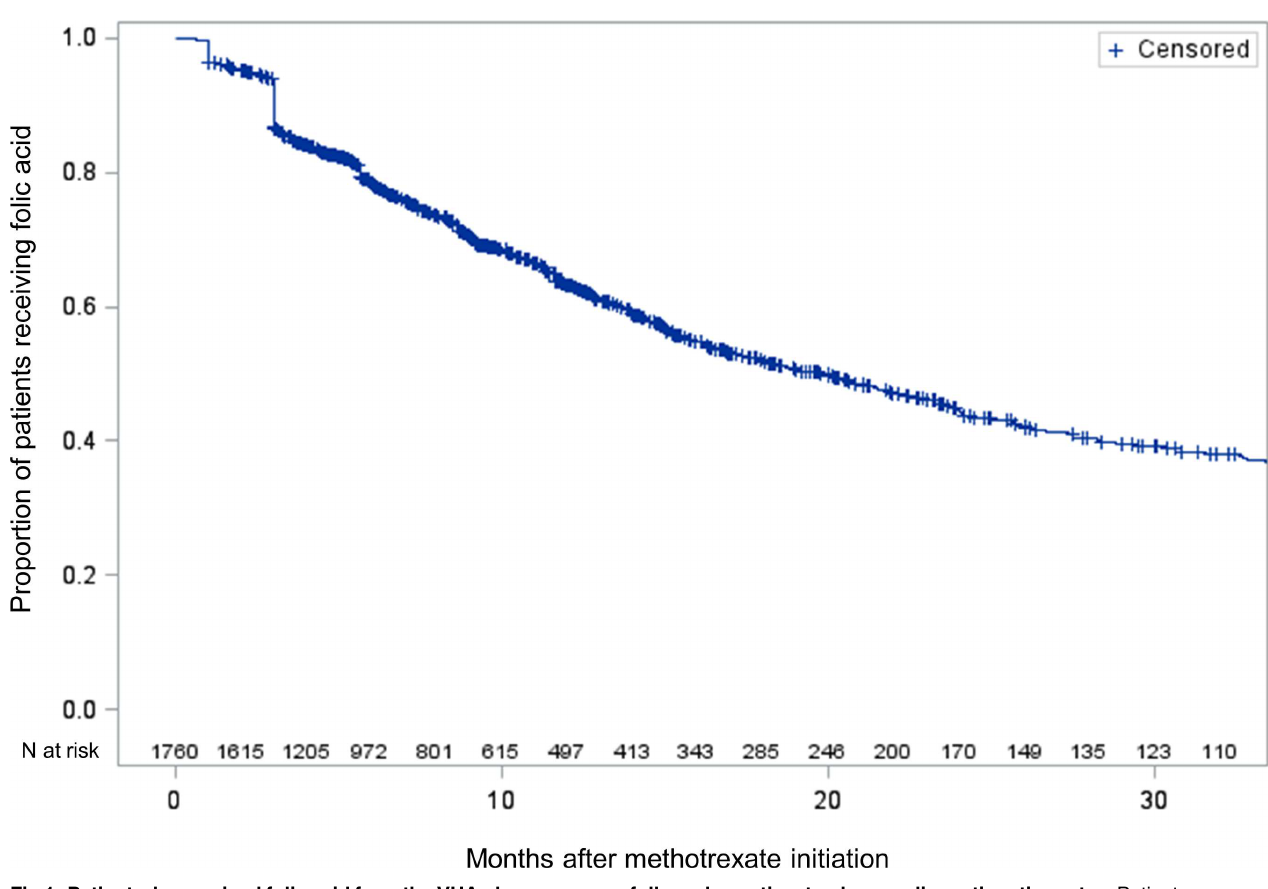
Fig 1. Patient who receivedfolic acid from the VHA pharmacywere followed over time to observe discontinuation rates. Patients were censoredat time of death or when patients went > 60 days without a supply of folic acid. Non-censored patients were followeduntil the end of exposureto MTX (end of days supply + 60 days).